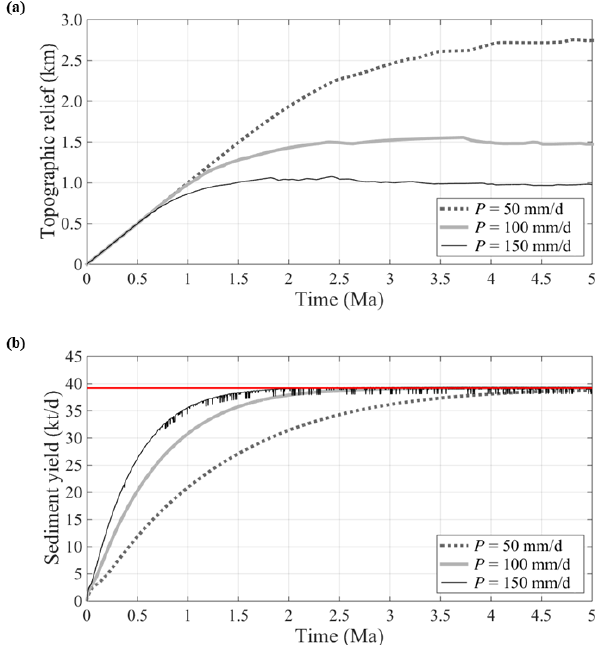
Figure 1. Results of no-feedback simulations. Time variations of (a) the topographic relief and (b) the sediment yield from the entire domain are